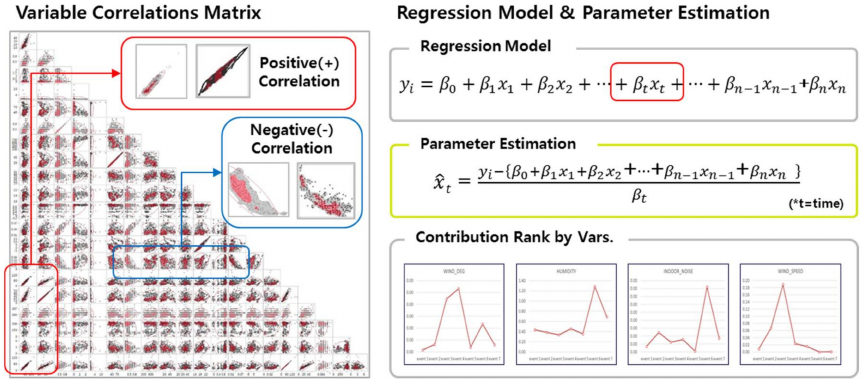
Figure 5. Analysis process in the first-round study.